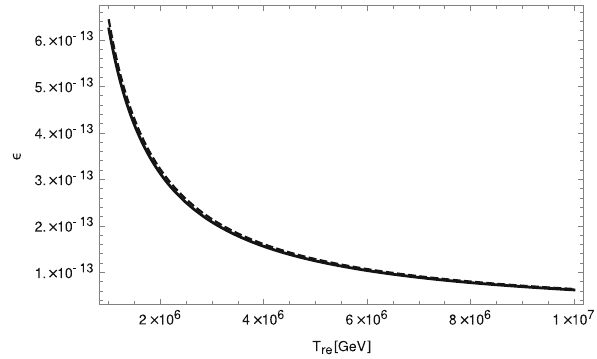
Fig. 15 CP-violation asymmetry factor, (cid:13) , as a function of the reheat- ingtemperatureafterinflation, T re ,fortheHiggs-likeinflationarypoten- tial and M 5 = 10 5 TeV. The solid curve corresponds to the SM, while the dashed curve to the MSSM